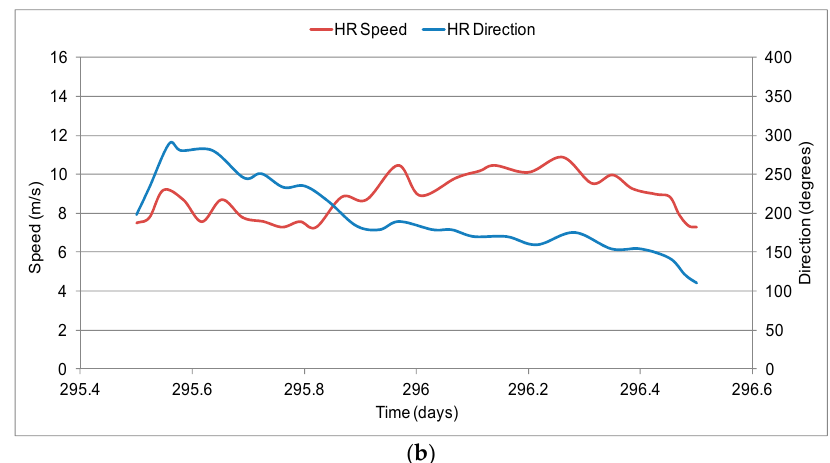
Figure 14. ( a ) Water elevation curve showing times of comparison on velocity vectors and ( b ) HR wind speed and direction at the location C3.